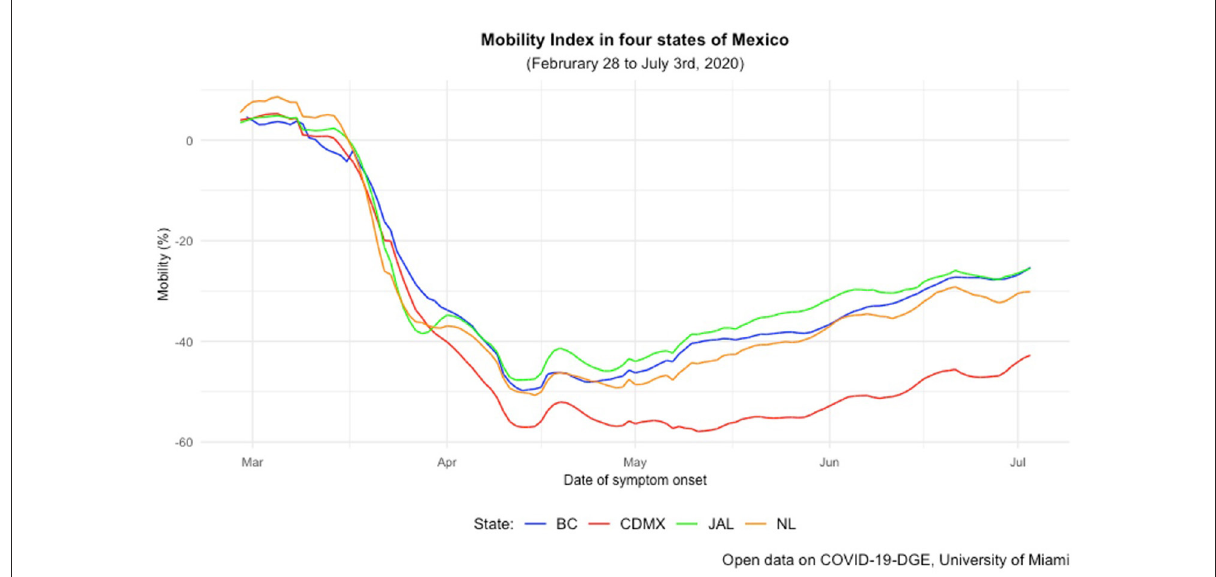
FIGURE2 Mobility index in four states from February 28th to July 3rd Mexico, 2020. The horizontal axis shows the period since the confirmation of the first COVID-19 case in Mexico, from February 28th, 2021, to July 3rd 2021. The vertical axis shows the percentage change in the mobility index documented by Google in a 10 to − 60% range. The blue line represents the mobility index across the specified period in Baja California, the red line Ciudad de Mexico, the green line Jalisco and the yellow line Nuevo Leon. Data were retrieved from the Observatory for COVID-19 in the Americas, University of